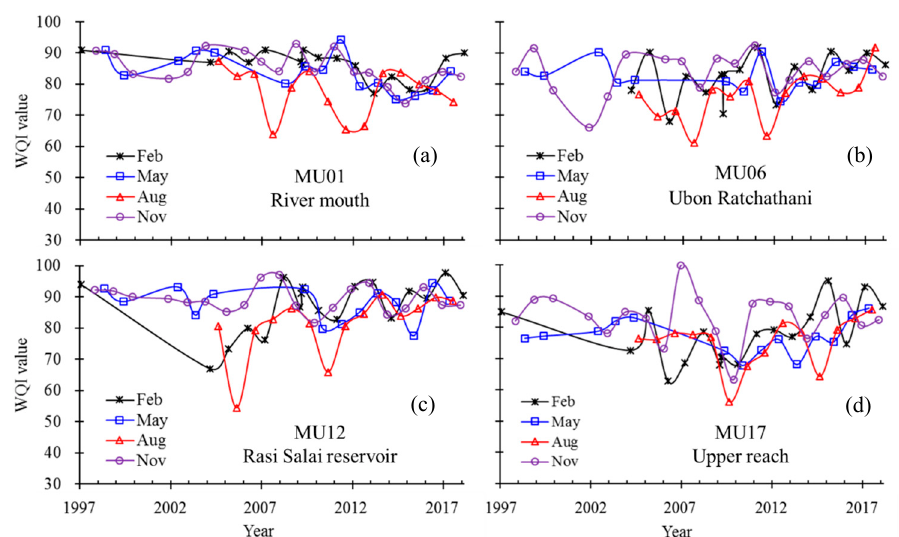
Figure 6. Temporal variations in the water quality index (WQI) values during four monitoring seasons in typical sites MU01 ( a ), MU06 ( b ), MU12 ( c ), and MU17 ( d ) over the past 20 years.